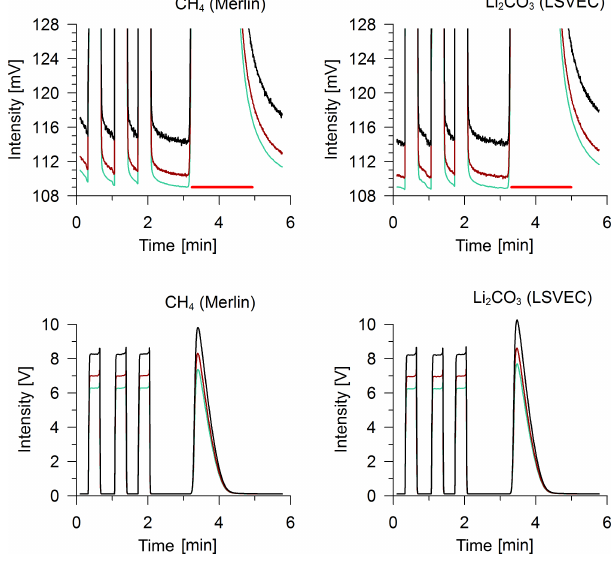
Figure 5. Chromatograms of δ 13 C–CH 4 calibrations using EA–IRMS with traces for m/z 44, 45 and 46 in green, brown and black respectively. Bottom panels show complete chromatograms of CH 4 and Li 2 CO 3 analyses while the two top panels zoom into the baseline of the traces. The first three square-shaped peaks stem from injections of a pure CO 2 WS while the more Gaussian-shaped peaks result from CH 4 - and Li 2 CO 3 -derived CO 2 analysis. The two red lines indicate the sections that the IRMS software uses for peak in- tegration (CO 2 peak widths are 101 and 100s for CH 4 and Li 2 CO 3 analysis